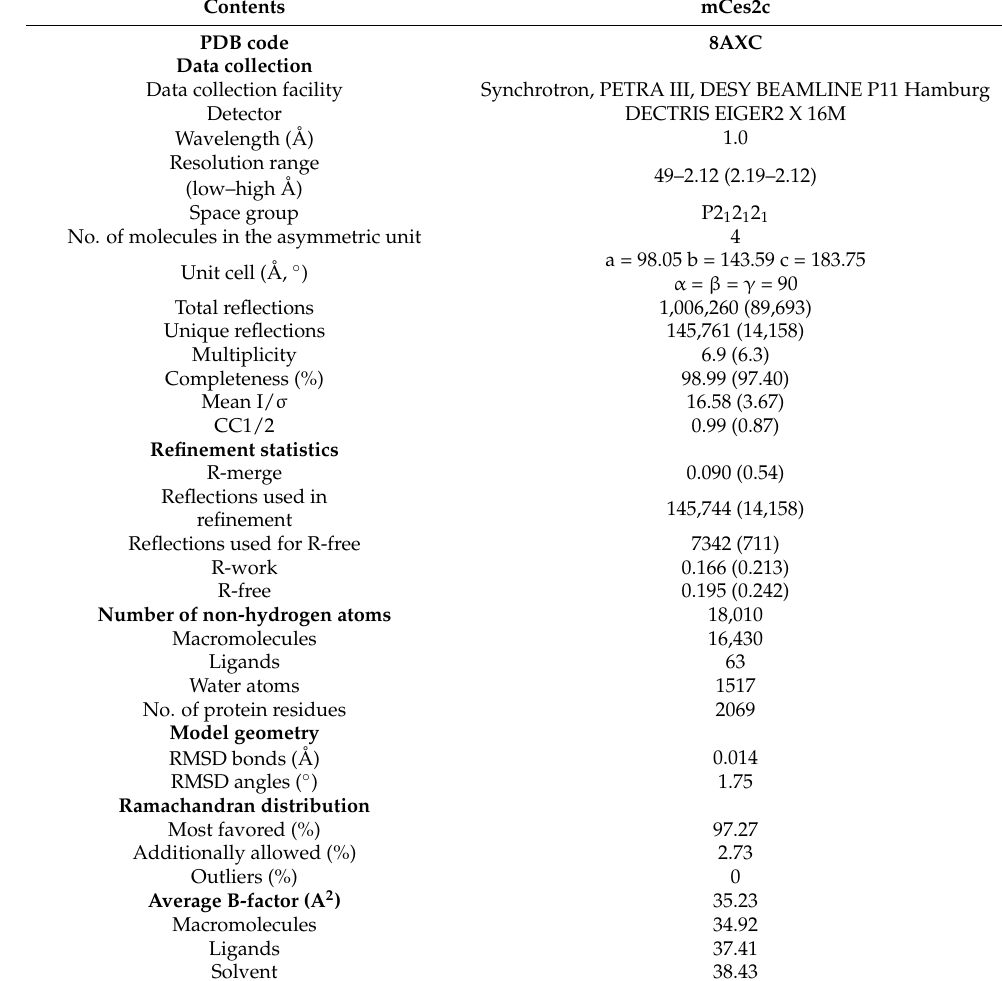
Table 1. Statistics of X-ray data collection and structure